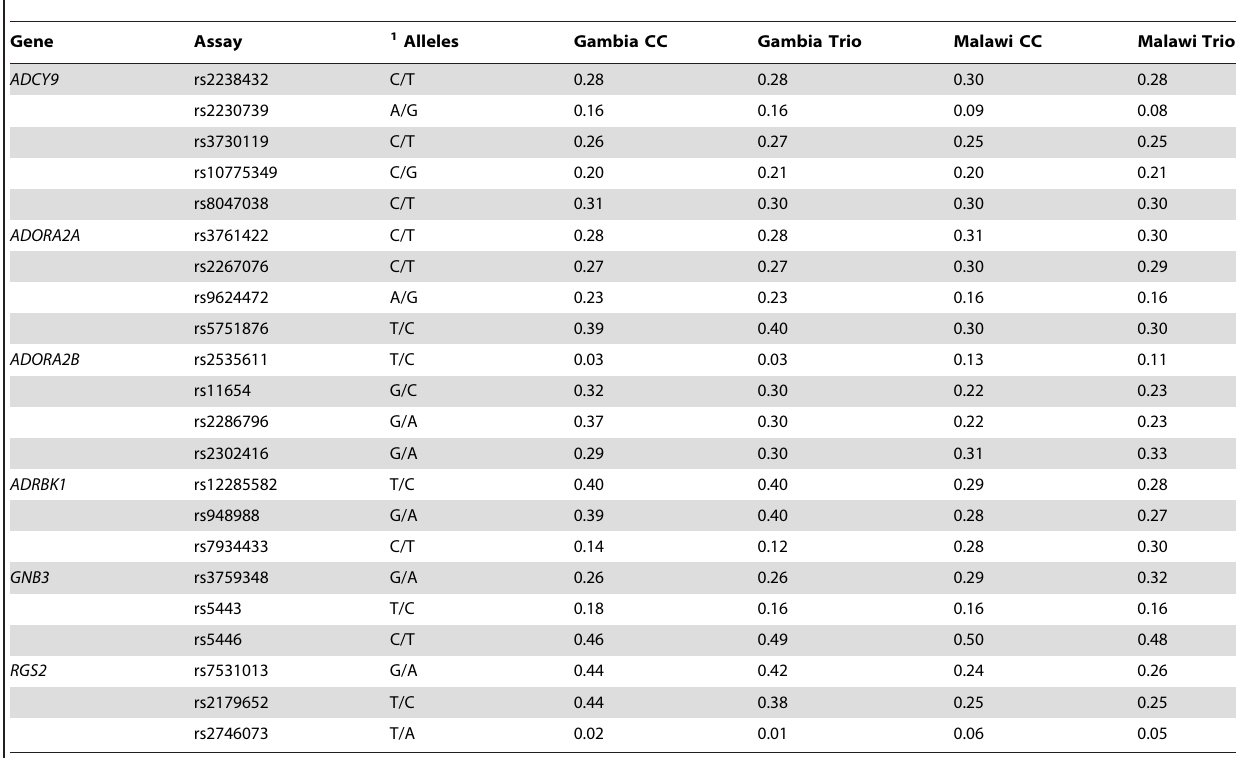
Table 1. SNP allele frequencies in the Gambian and Malawian case-control and family trio studies.